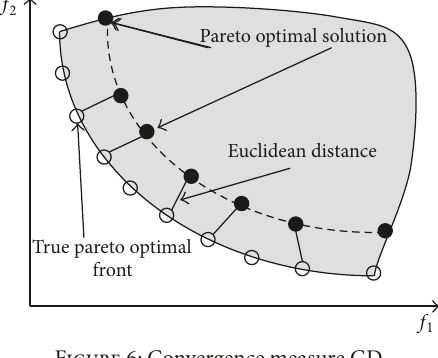
Figure 6: Convergence measure